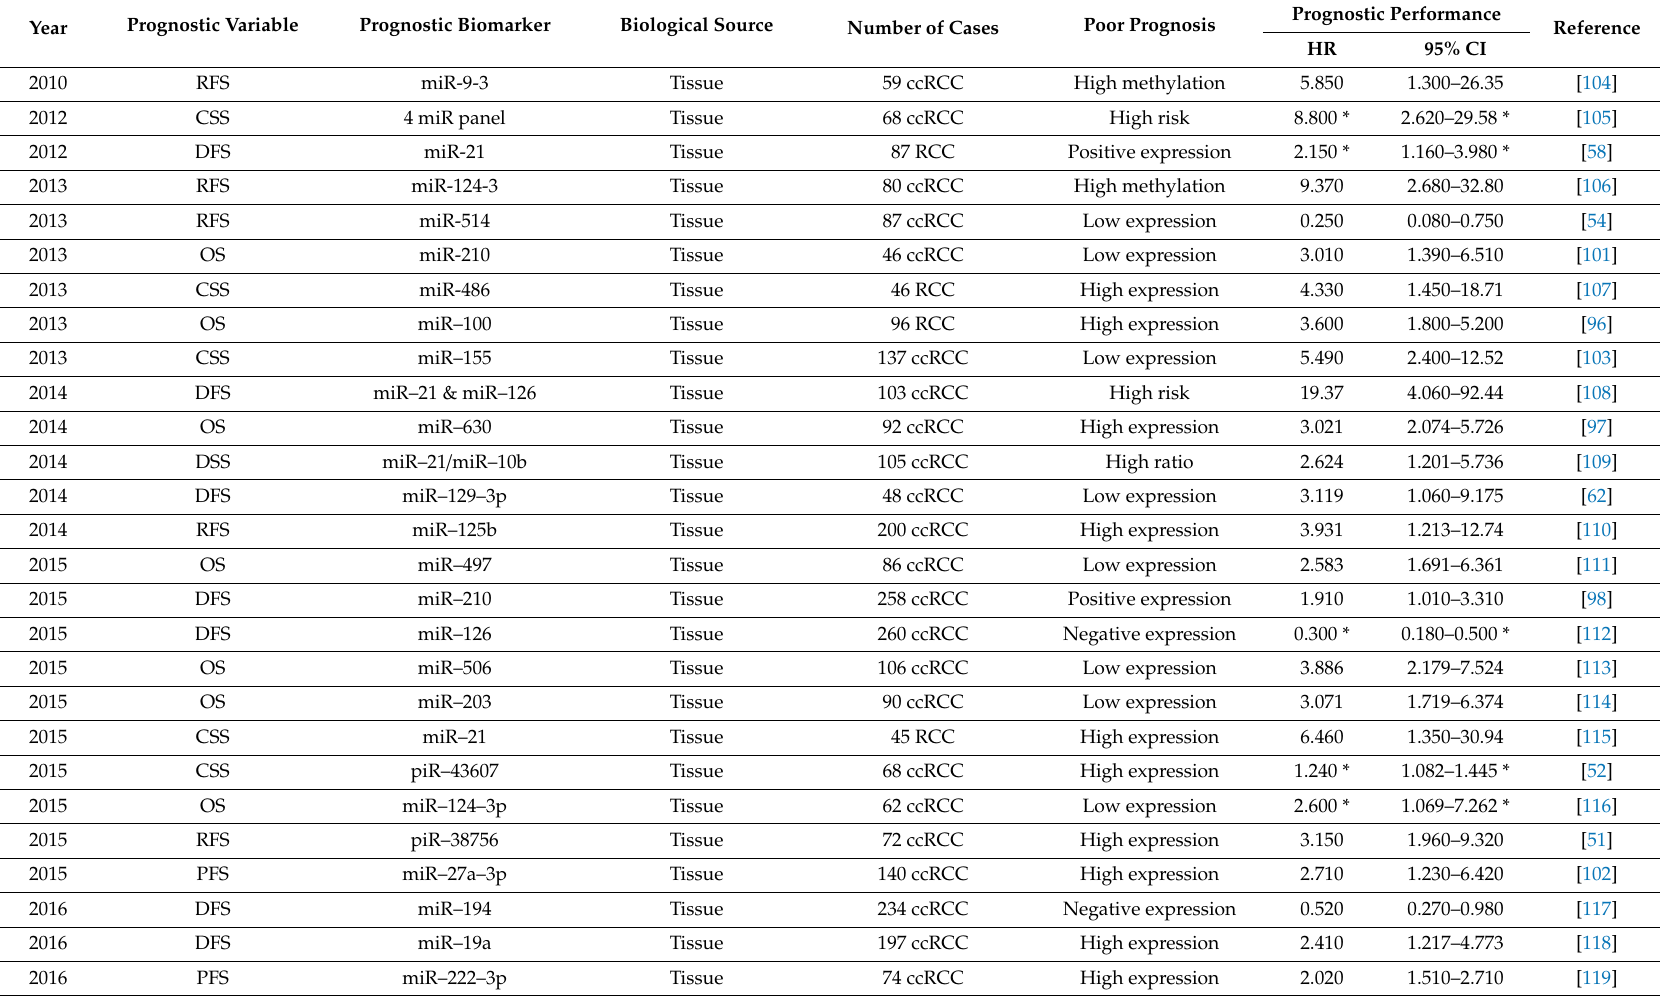
Table 3. List of potential prognostic Renal Cell Carcinoma (RCC) biomarkers in tissue